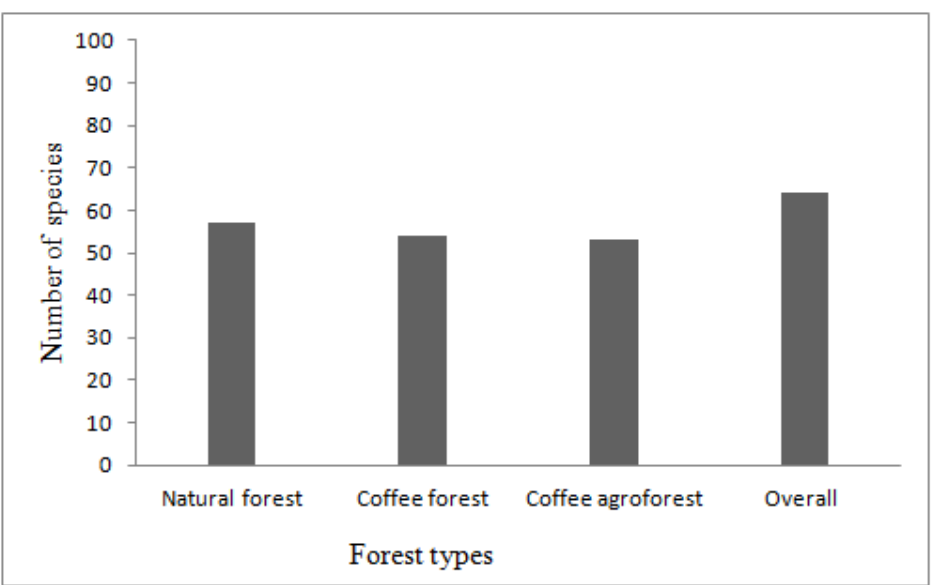
Figure 2. Each and overall woody species recorded in the natural forest, coffee forest and coffee agroforest and overall.